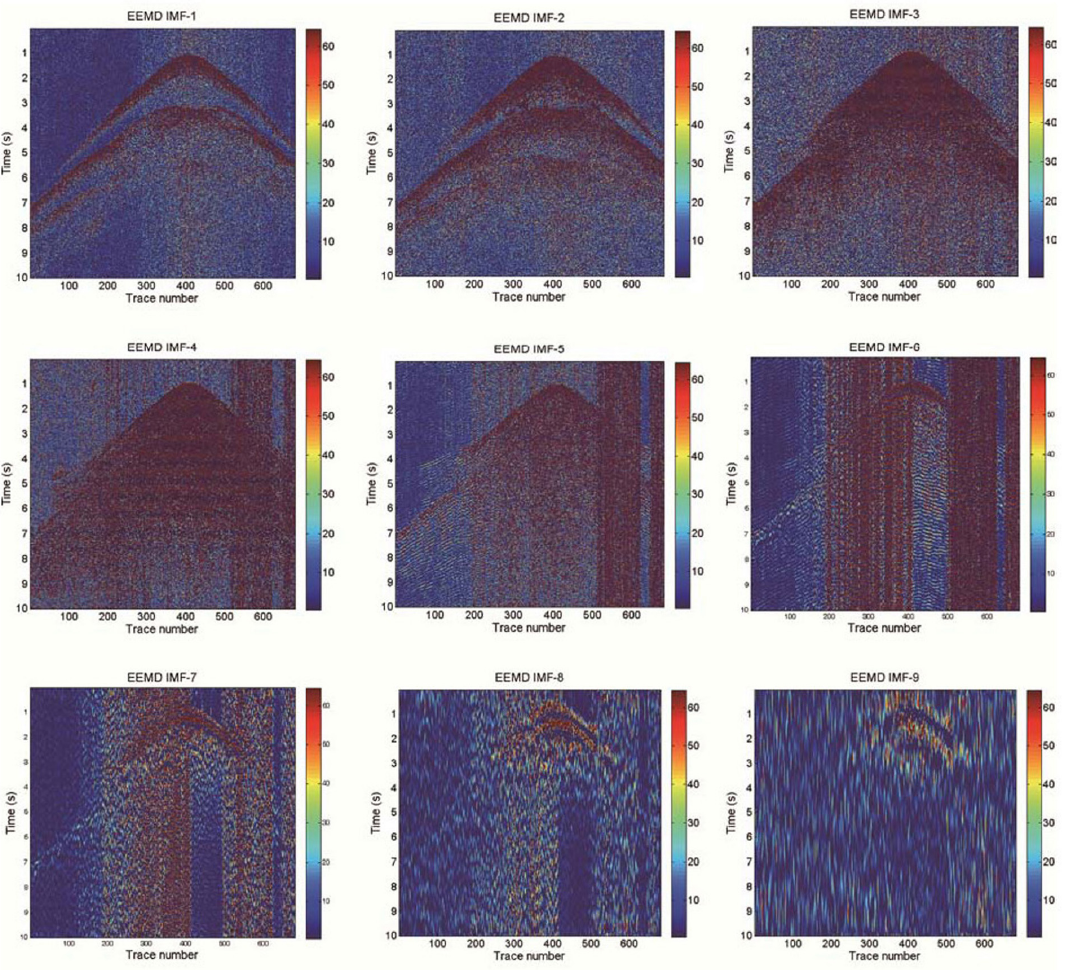
Fig. 7. Filter bank of the original OBS